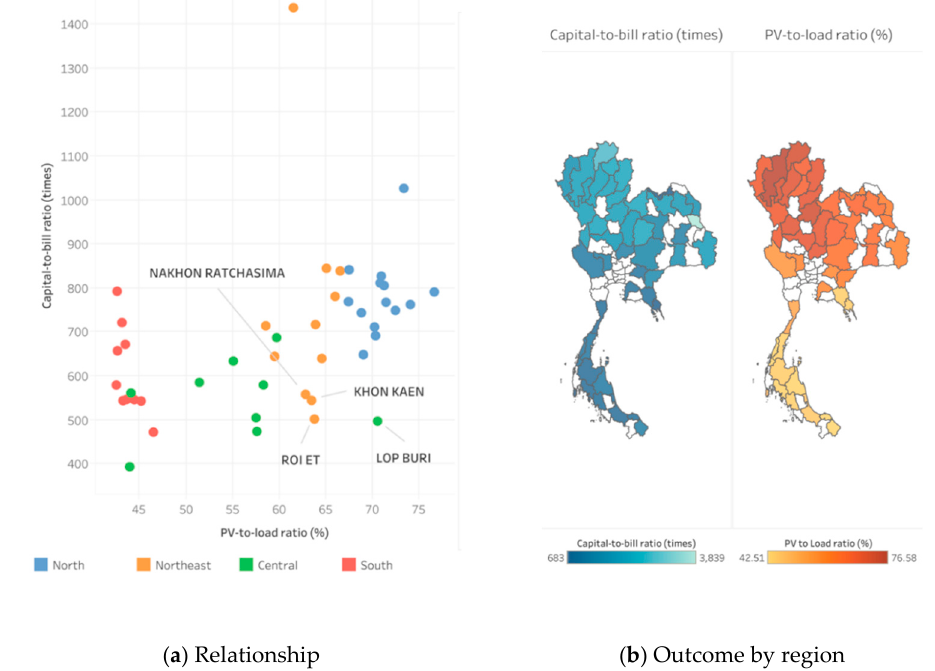
Figure 14 . MGS customer investment hotspots (under a net billing compensation scheme with a 1 THB/kWh buyback rate). 1 THB/kWh buyback